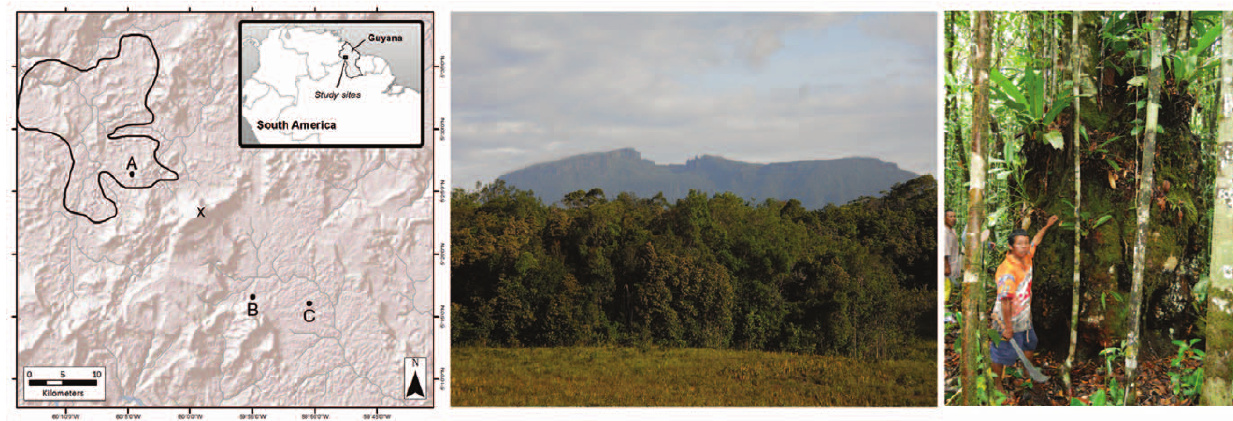
Figure 1. Location and appearance of forests dominated by Pakaraimaeadipterocarpacea. Map (left) showing the central Pakaraima Mountain region of western Guyana including the Upper Potaro and Mazaruni River Basins. The tallest mountain in Guyana, (Mt. Ayanganna, 2041 m) is indicated by an X. This study was conducted in Pakaraimaea dipterocarpacea - Dicymbe jenmanii stands at 800 m elevation at the edge of the Pegaima savanna, with location indicated by A. The approximate extent and location of the savanna ecosystem is shown with a black polygon; the rest of the map area is forested. The locations of other study plots in closed-canopy Dicymbe rainforests at , 800 m elevation along the Potaro river are indicated by B (Henkel et al. [25]) and C (Smith et al. [9]). The center photo shows an ecotone of savanna with fringing forest dominated by Pakaraimaea dipterocarpacea , Pegaima savanna, Upper Mazaruni Basin, Guyana. The photo on the right shows an individual tree of Pakaraimaea dipterocarpacea measuring 212 cm diameter at breast